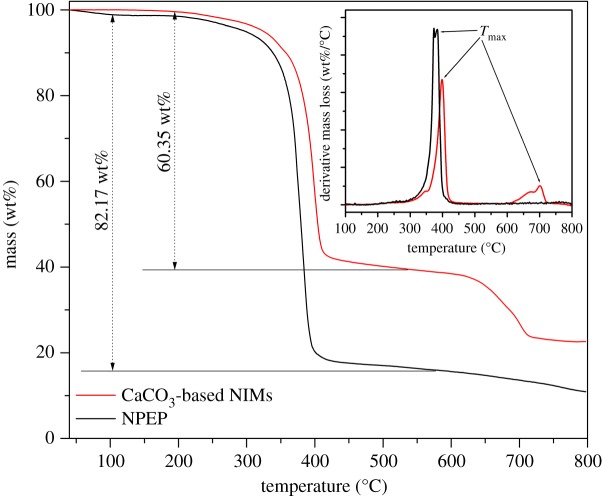
TGA and DTG thermograms of CaCO3-based NIMs and pristine NPEP.